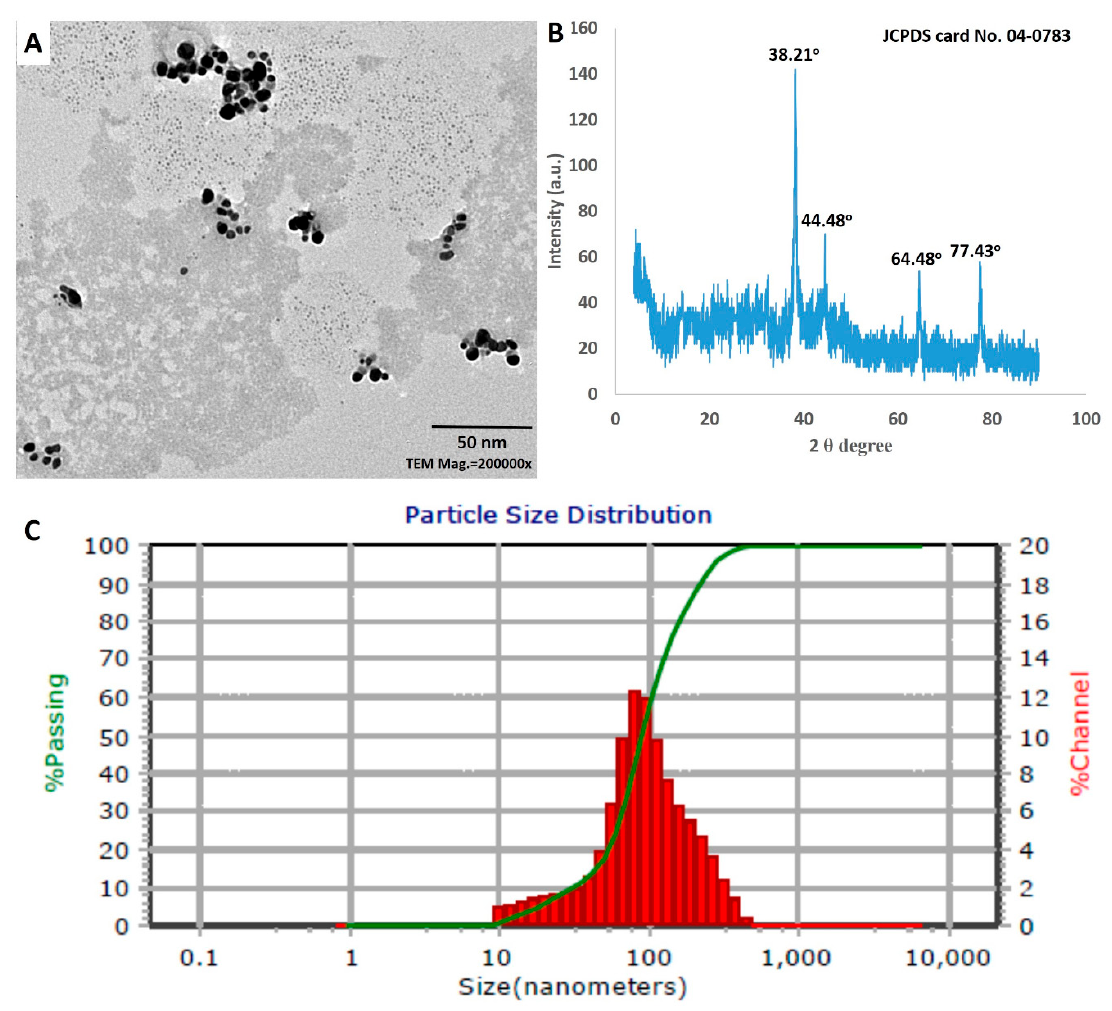
Figure 4. Characterization of Ag-NPs synthesized by Streptomyces antimycoticus L-1: ( A ) transmission electron microscopy (TEM) image; ( B ) X-ray diffraction (XRD) analysis; ( C ) dynamic light scattering (DLS) analysis.